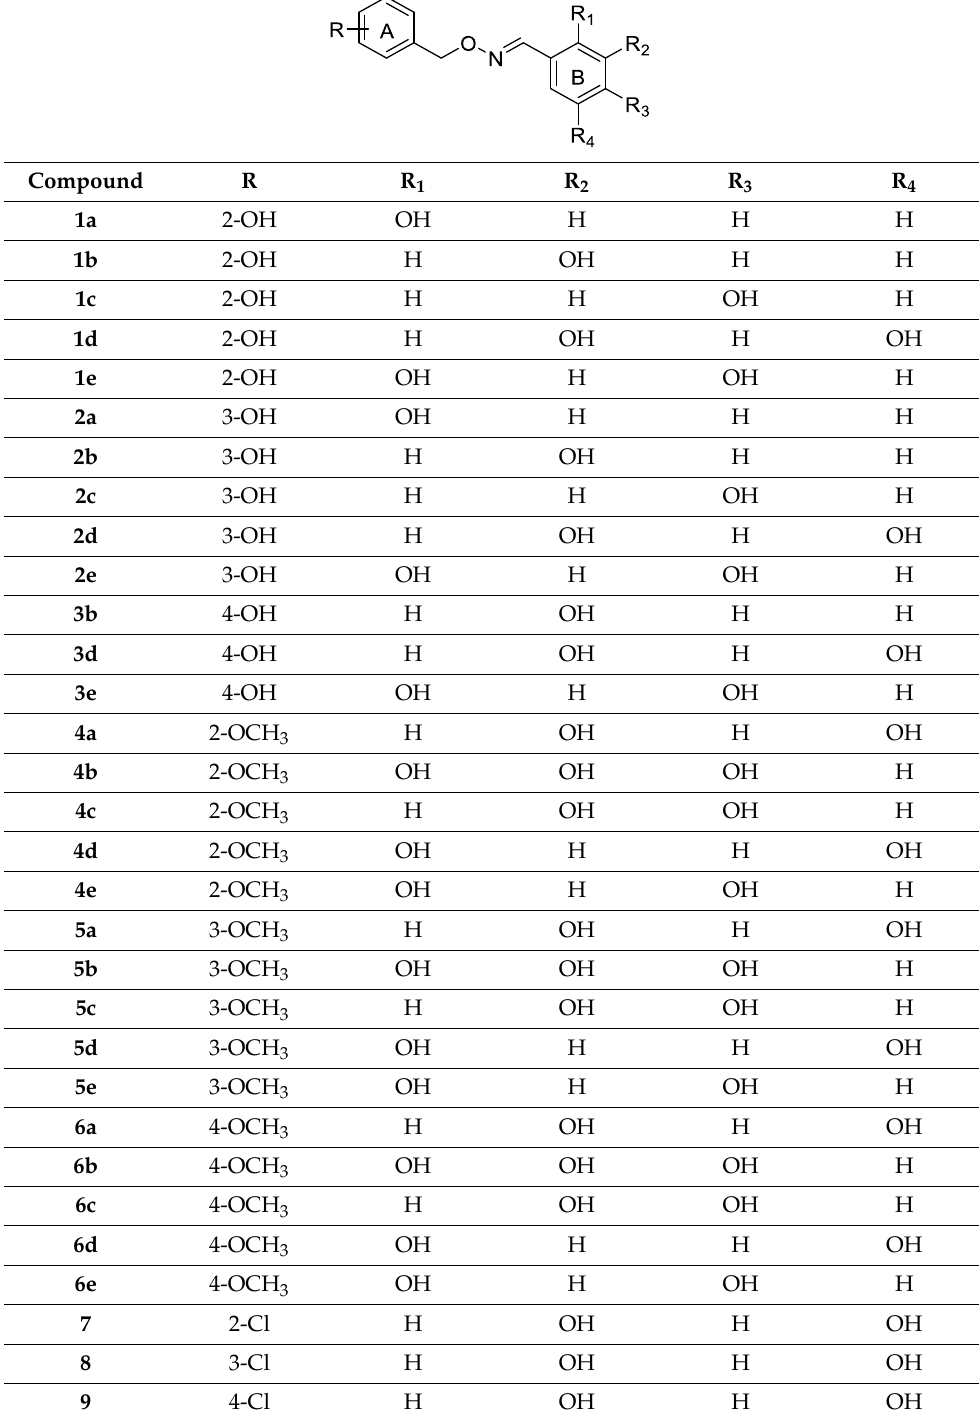
Table 1. Substitution pattern of compounds of the in-house library 1a–e , 2a–e , 3b, d–e , 4a–e, 5a–e, 6a–e, and 7–9 .